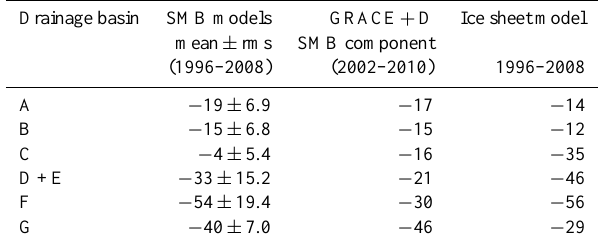
Table 3. Recent SMB changes in six main drainage basins. Val- ues for four SMB model estimates are averaged from Vernon et al. (2013). The GRACE observational mass change record is corrected for ice discharge D based on Fig. 2 in Sasgen et al. (2012). SMB changes are given in Gtyr − 1